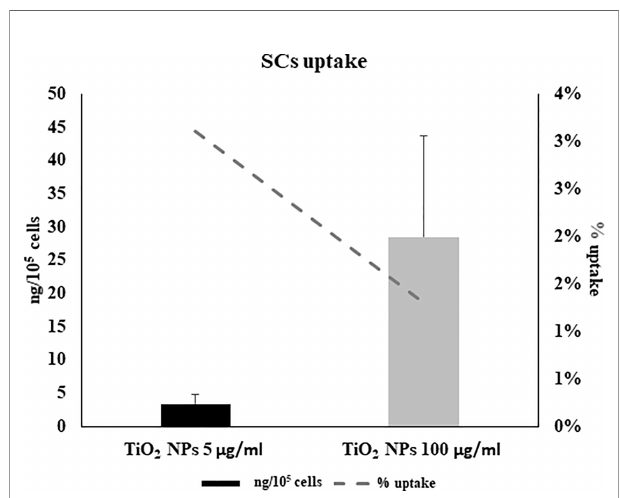
FIGURE 4 | Cellular uptake by inductively coupled plasma-optical emission spectrometry (ICP-OES). Percentage of internalized nanoparticles (dotted grey line) and amount of metal adsorbed per cell number (expressed as ng/10 5 ) in SCs 5 h of incubation with TiO 2 NPs 5 (black bar) and 100 µg/ml (grey bar) evaluated by ICP-OES analysis. Data represented as mean ± SEM of three independent experiments, each are performed in triplicate.